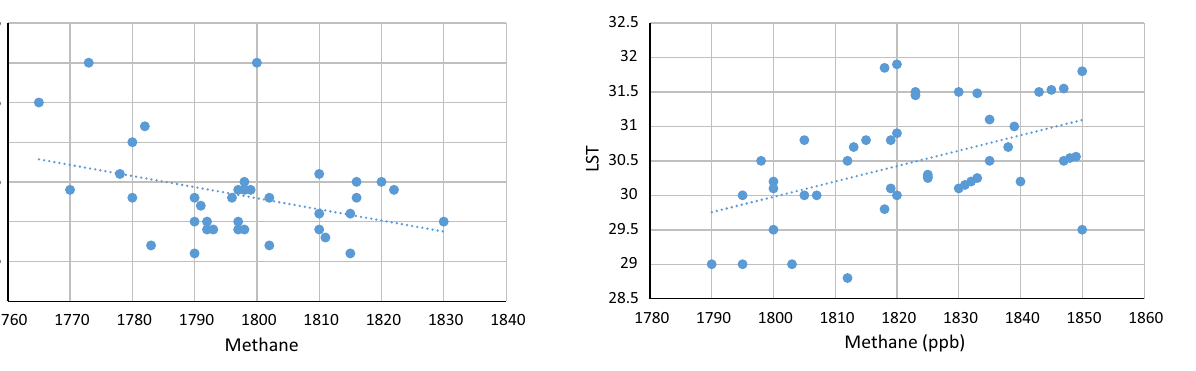
Fig. 9 Relationship between methane and NDVI in winter